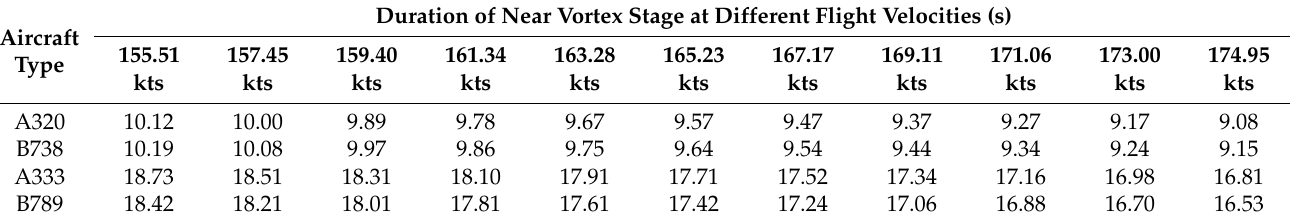
Table 5. Duration of near-vortex phase for each aircraft at different